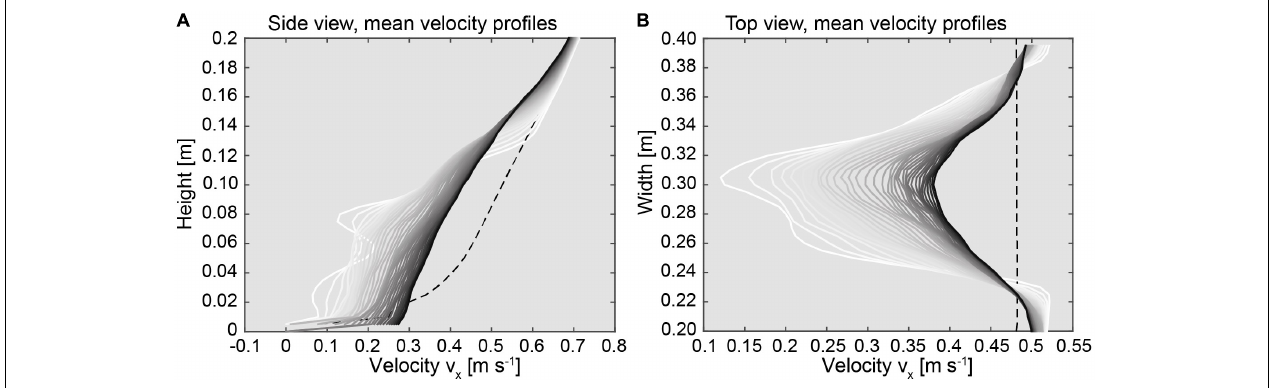
FIGURE 6 | (A) Profiles indicating the downstream velocity component with respect to model height ( Z = 0.05 m). (B) Profiles indicating the downstream velocity component with respect to model width ( Y = 0.15 m). The 37 individual profiles were extracted from the model between 1.1 and 2.0 m. The white color refers to profiles that were extracted close to the coral, whereas the black colors references to profiles that were located further downstream of the coral. The dashed line indicates the profile that was extracted before the coral. For comparison, the dashed lines refer to an undisturbed reference profile measured at 0.9 m in the upstream reach of the coral.